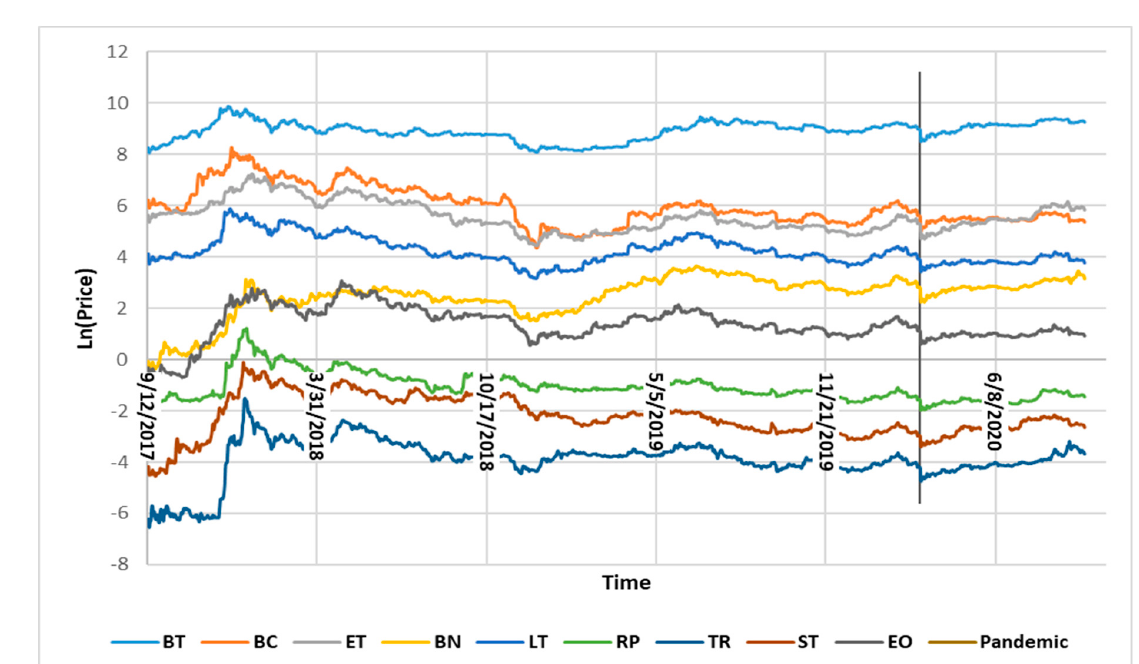
Figure 1. Co-movements of